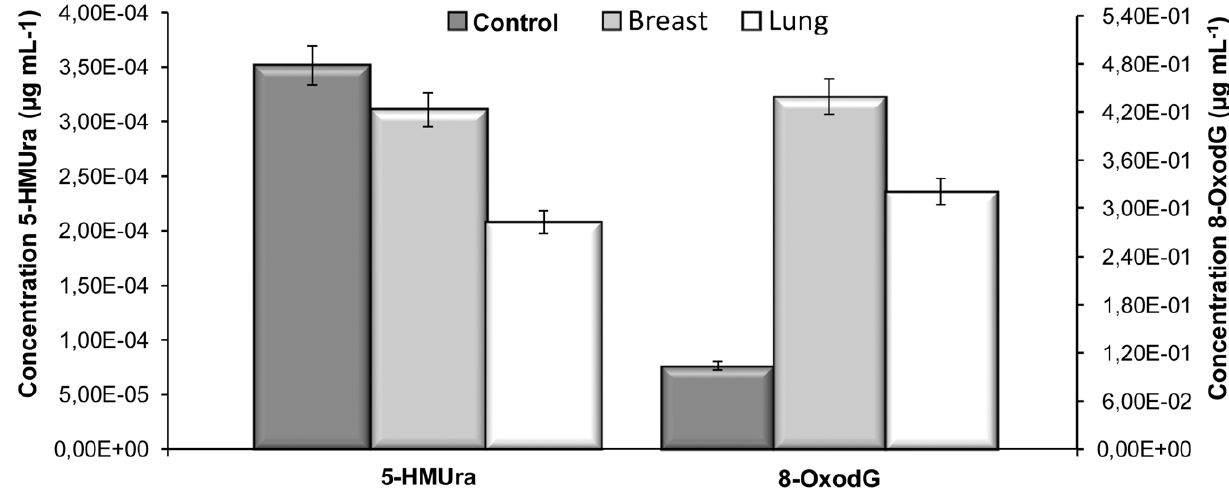
Figure 4. Total concentration of oxidatively damaged DNA investigated biomarkers in normal controls, and in breast and lung cancer patients.